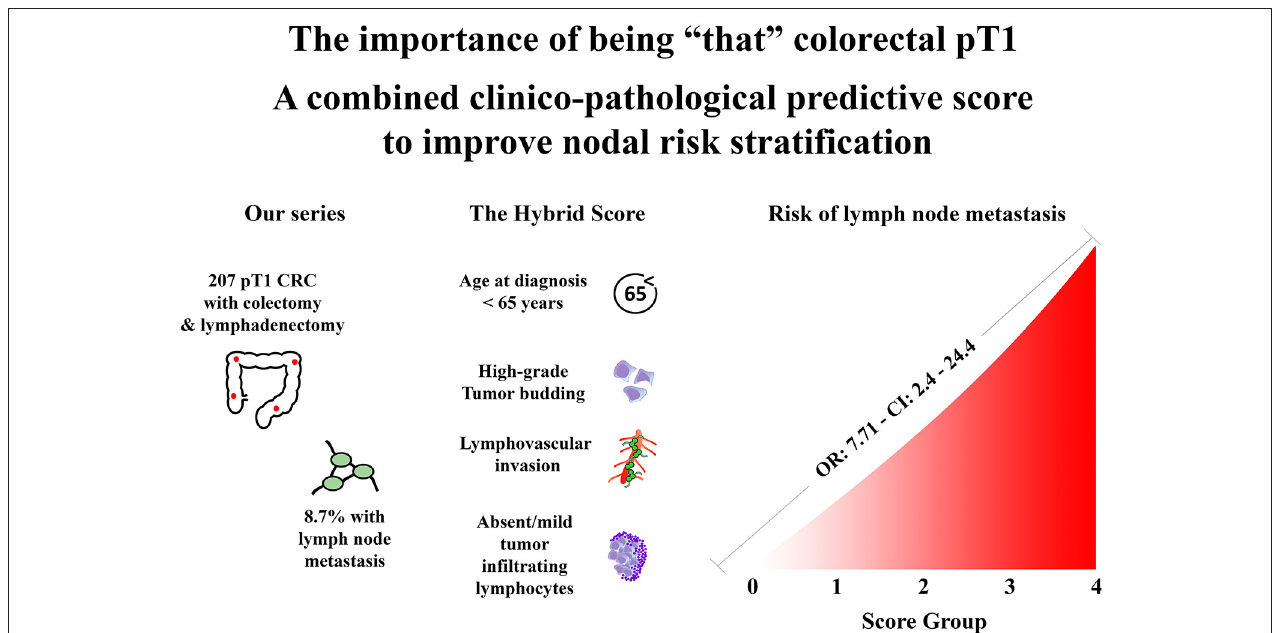
FIGURE 3 | Graphical representation of our